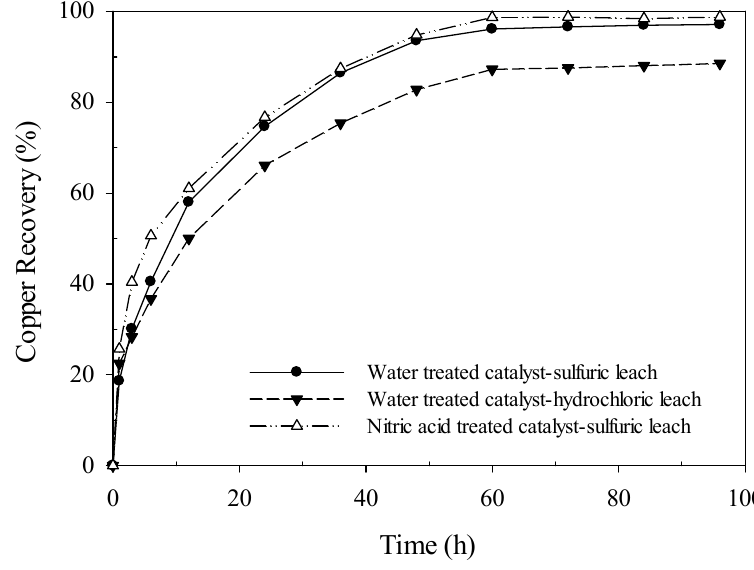
Figure 8. Effect of acid type and catalyst pretreatment on copper recovery. Figure 8. E ff ect of acid type and catalyst pretreatment on copper